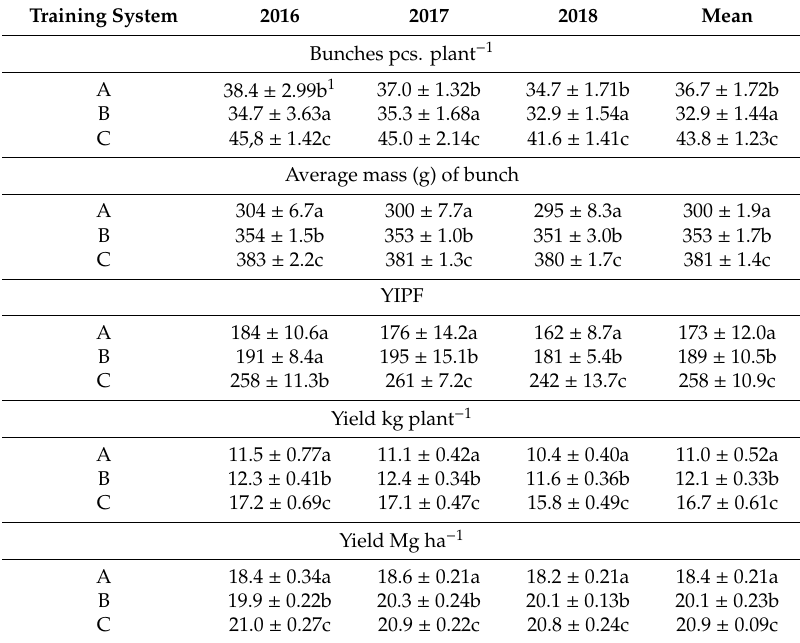
Table 4. The productivity of the grape depending on the training systems